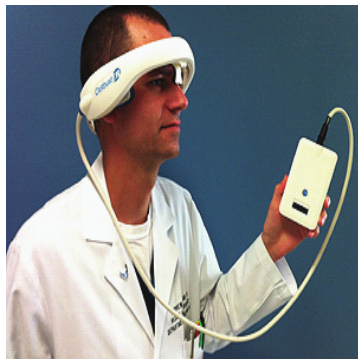
Figure 4: The Fore-sight monitor for cerebral blood flow in stroke treatment. Courtesy of Casmed, Brandord, CT,